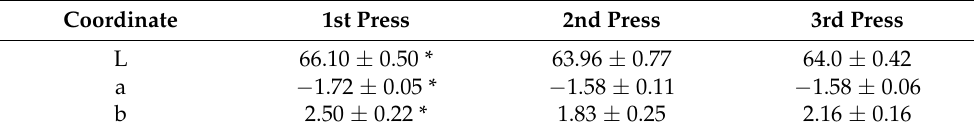
Table 2. Color coordinates of baseline (first press) and repressed groups.